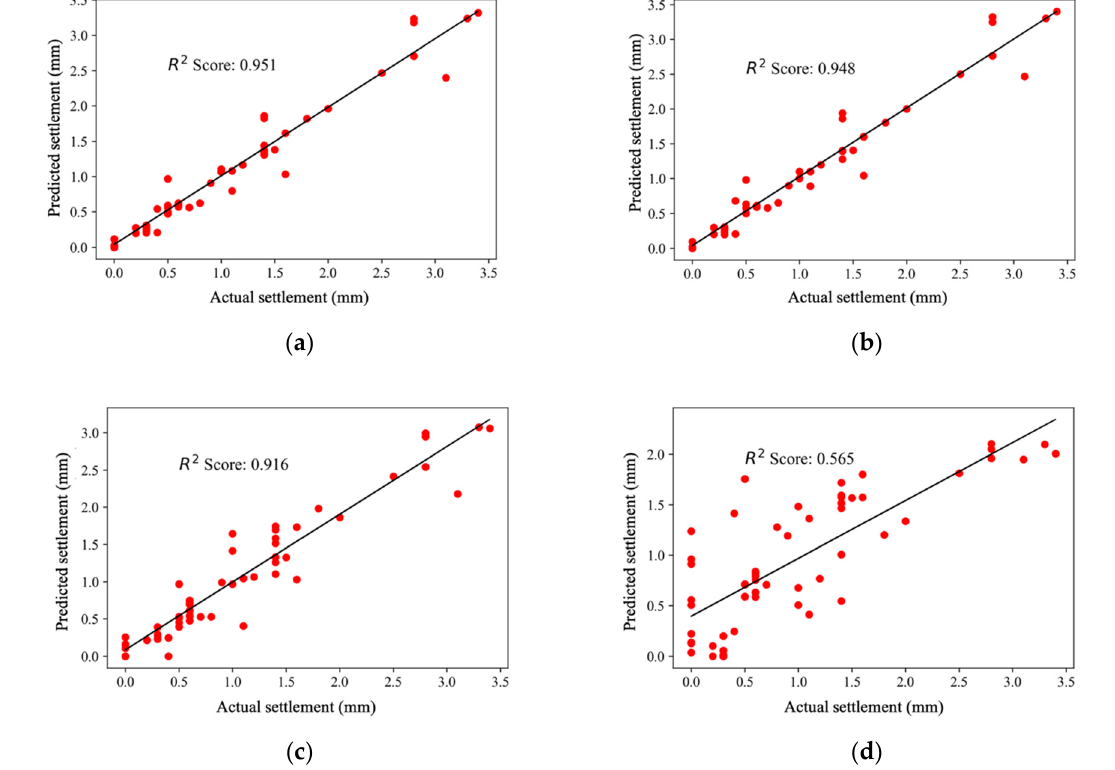
Figure 9. R 2 comparisons of machine learning models. ( a ) SGM performance; ( b ) SVR perfor- mance; ( c ) MLPR performance; ( d ) LR performance. ( c ) MLPR performance; ( d ) LR